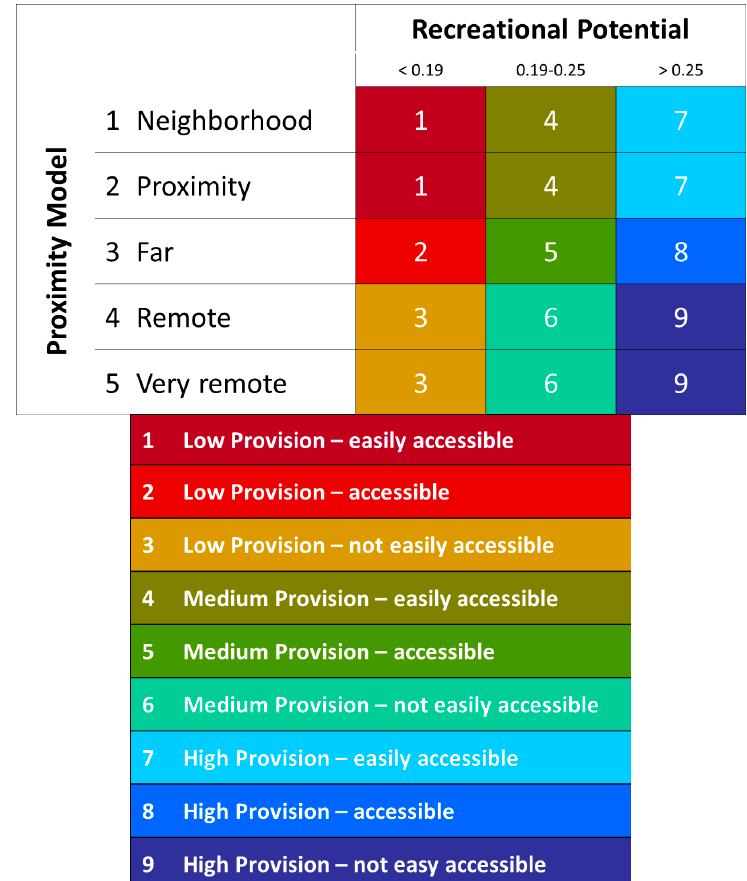
Figure 1. The Recreation Opportunity Spectrum (ROS) classes according to Paracchini et al. [55]. In this study, ROS served to classify the biophilic quality (BQ) of the settings: a ROS value from 1 to 4 indicates a setting with low BQ; a value from 5 to 9 indicates a setting with high BQ.